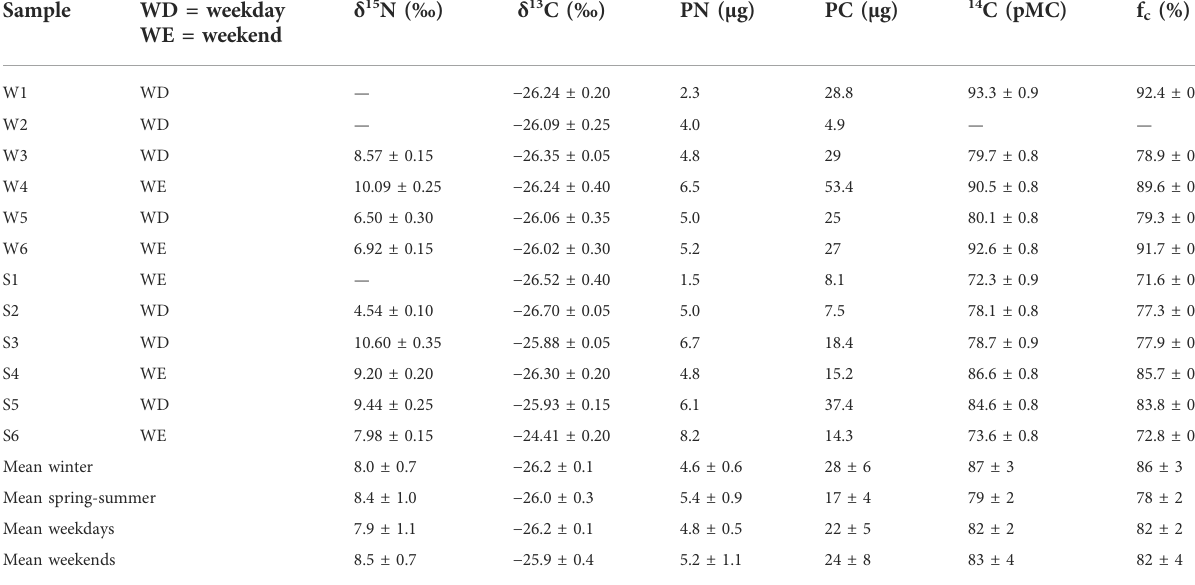
TABLE 3 Values (± corresponding uncertainties) of stable isotope measurements of nitrogen and carbon ( δ 15 N and δ 13 C, respectively), particulate nitrogenandcarboncontent(PNandPC,respectively),amountof 14 Cexpressedinaunitofpercentmoderncarbon(pMC),andthecontemporary carbon fraction f c (%) for each analyzed PM2.5 sample. The weekday/weekend indication has been also reported. The corresponding mean values (± standard error of the mean) for winter, spring-summer, weekday, and weekend samples have been also reported.